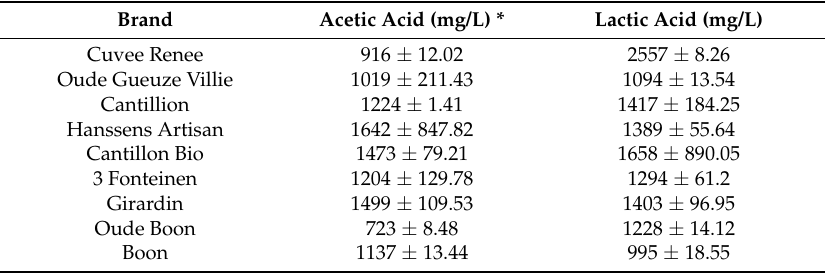
Table 6. Comparison of Acids within Commercial Brands of Lambic Beer. Brand Acetic Acid (mg/L) * Lactic Acid (mg/L) Cuvee Renee 916 ± 12.02 2557 ±